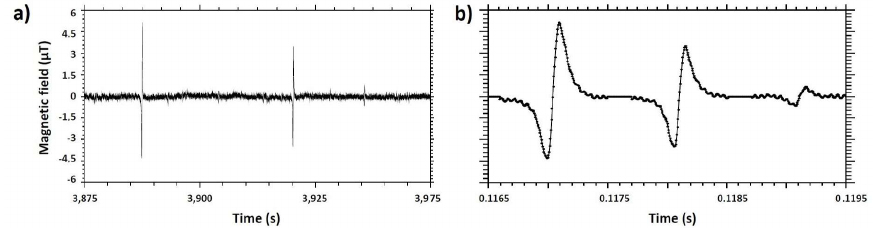
Figure 2. Experimental data. ( a ) Raw experimental recording. ( b ) Recording of the software-selected portions (the same 3 signals are